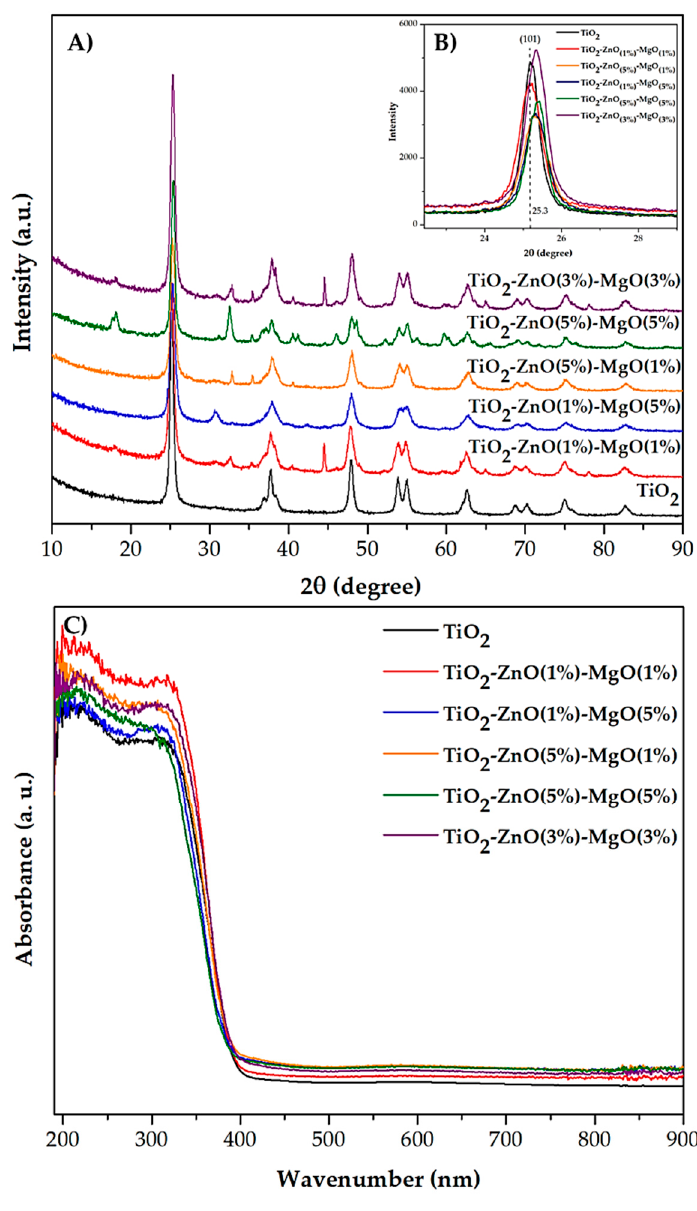
Figure 4. X-ray diffraction patterns ( A , B ) and UV-Vis ( C ) spectra of mixed oxide materials.